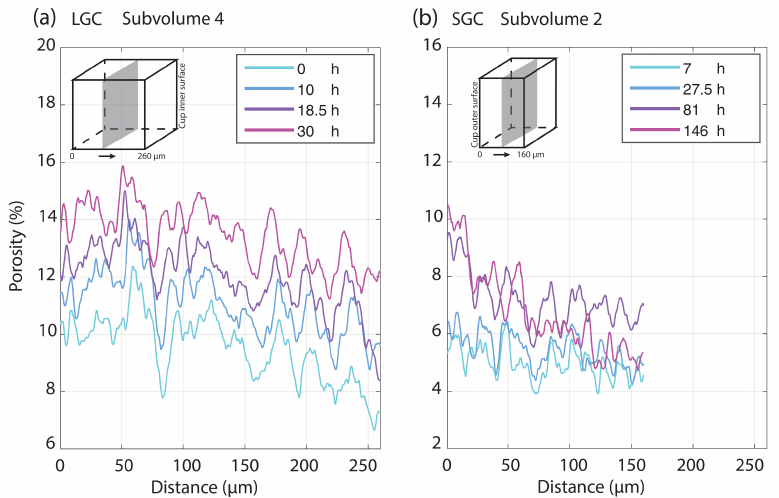
Figure 9. Porosity profiles of (a) LGC and (b) SGC along the radial direction of the sample cup. Different colors indicate reaction time lapse.